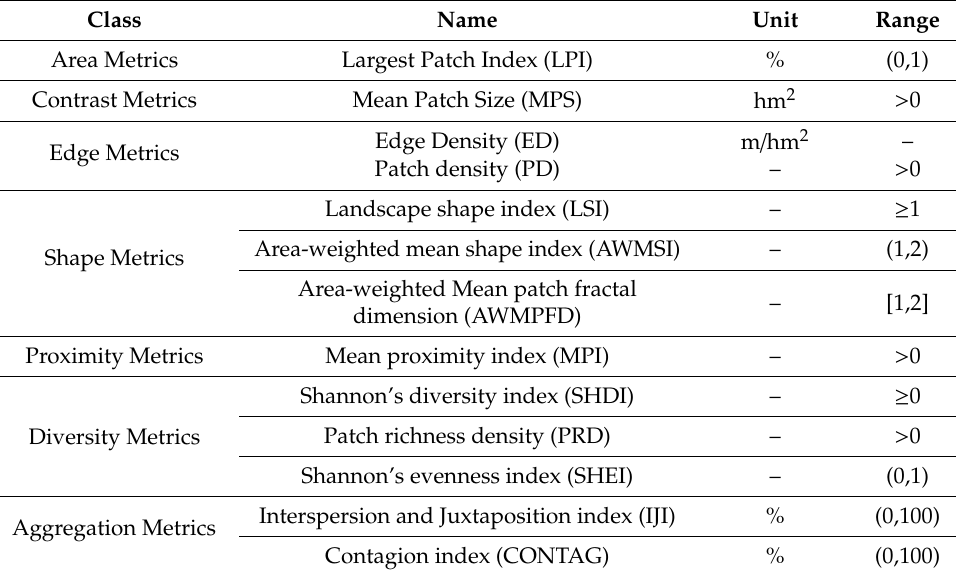
Table 3. Landscape indicators used in this